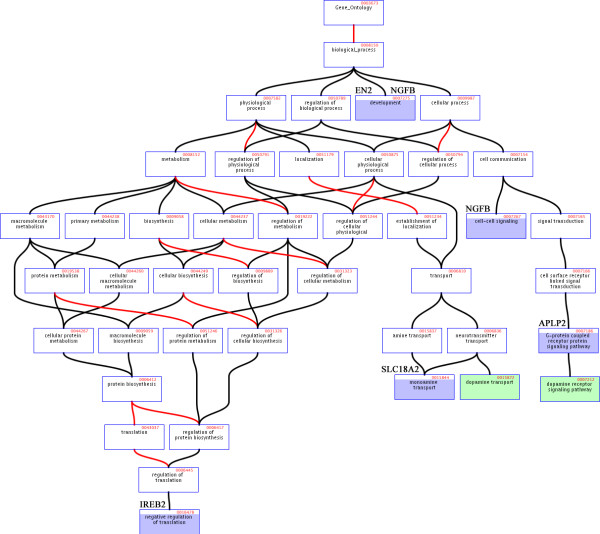
Gene Ontology biological process categories associated with the five genes selected, but not present in reference databases, as related to Parkinson's disease. Boxes in dark purple represent the most specific biological process categories the selected five genes have been annotated with (associated gene symbol above the box). Because of inheritance in the Gene Ontology hierarchy, genes are also annotated with all parent categories. Boxes in light green denote dopamine biological process categories that are direct child or sibling of two of the most specific biological process categories associated with two of the selected five genes. Note that motor symptoms in Parkinson's disease are generally thought to result from deficiency or dysfunction of dopamine or dopaminergic neurons in the substantia nigra [22]. Box category links in dark black represent IS-A relations, whereas those in light red represent PART_OF.